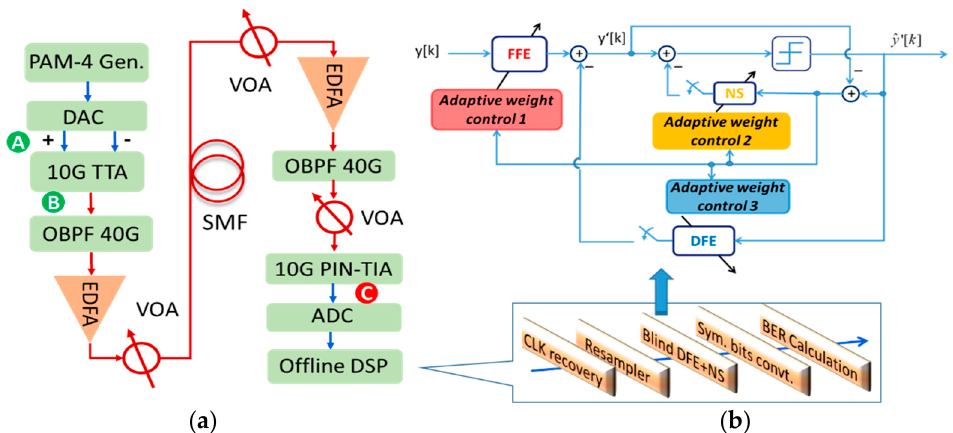
Figure 1. ( a ) Experimental setup of a 40 Gb/s lane rate next generation passive optical network (NG-PON) downstream link using pulse amplitude modulation (PAM-4) and the diagram of the receiver digital signal processing (DSP). ( b ) Detailed architecture of the nonlinear equalizer.